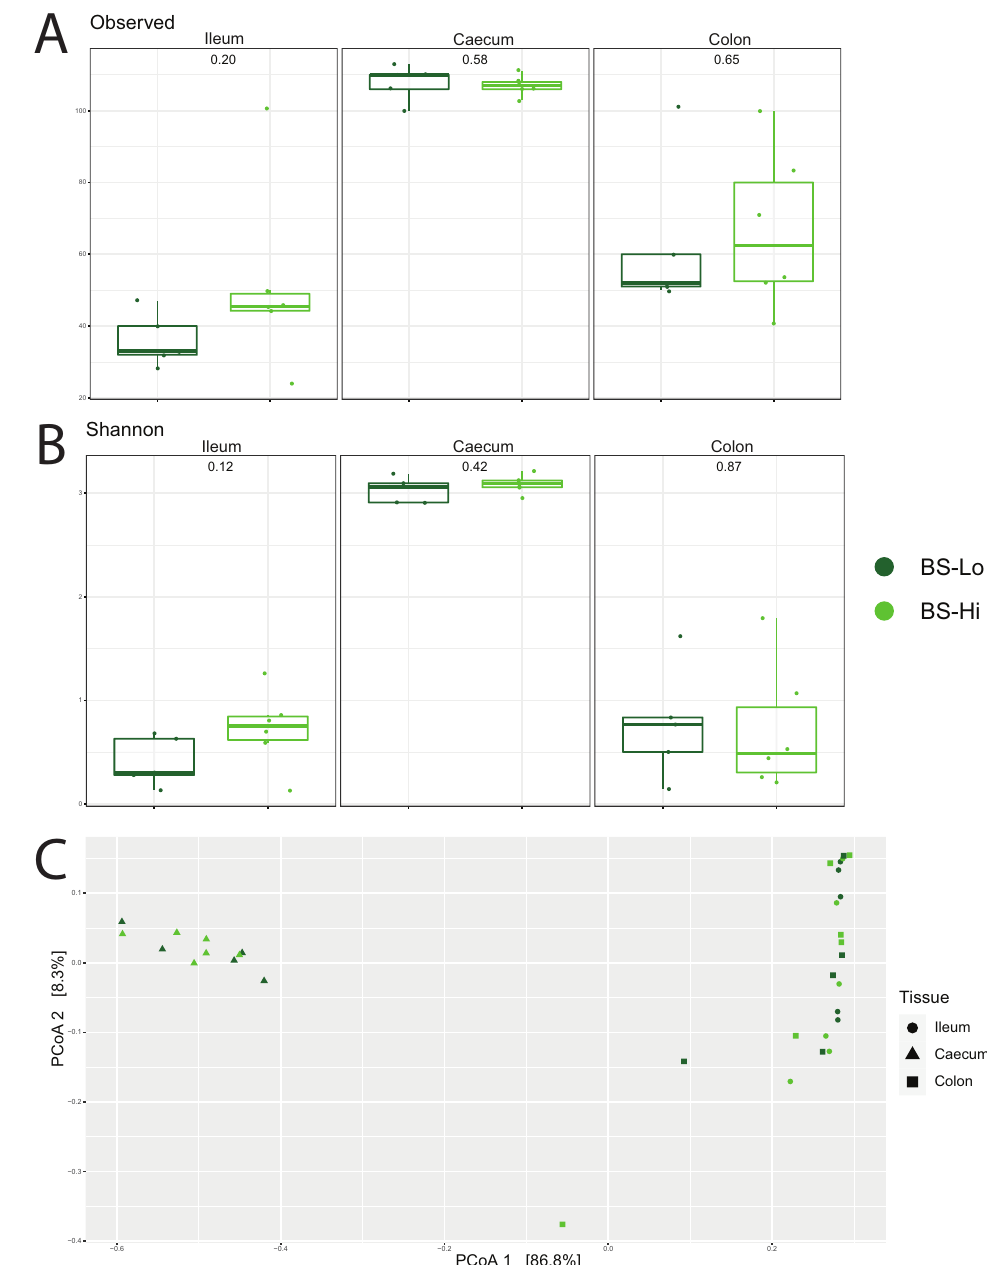
Figure 2. Cont . Figure 4. Microbiota results of various intestinal segments from hens in the high and low breaking strength. ( A ) shows the microbiota diversity, observed species, for the tissues, whereas ( B ) shows the Shannon index. ( C ) shows the microbiota composition for the ileum (circles), caecum (triangles), and colon (squares), in principal coordinate analysis (PCoA) plots. Dark green represents the low breaking-strength (BS-Lo) samples, whereas light green represents the high breaking-strength (BS- Hi)